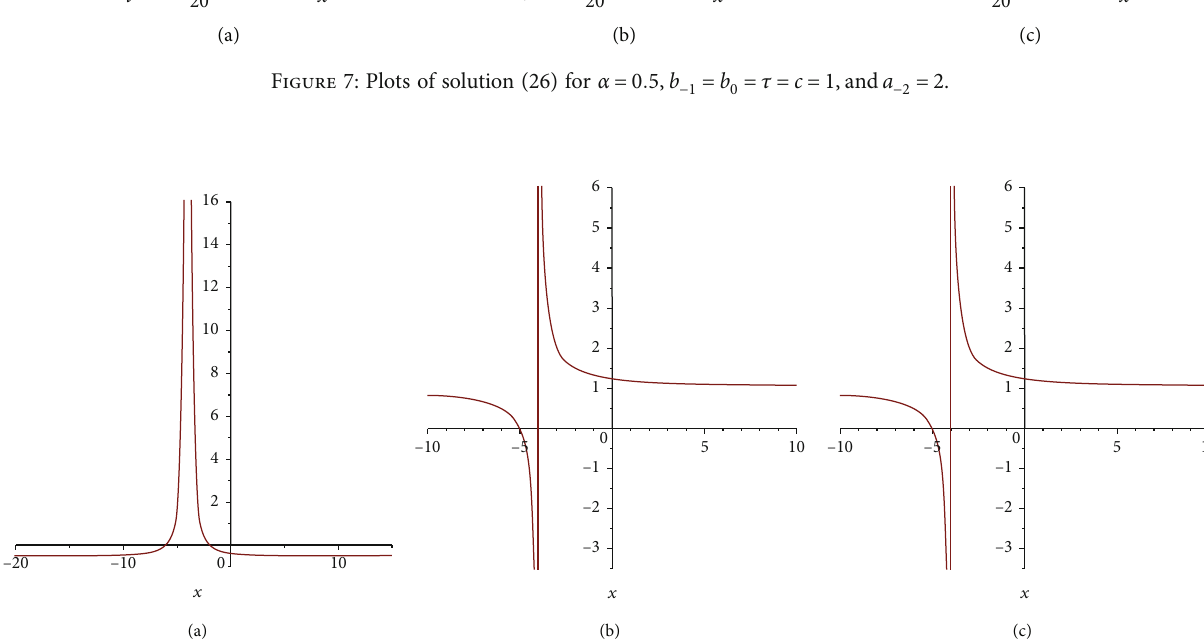
Figure 8: Plots of solution (26) for α = 0 : 5, b